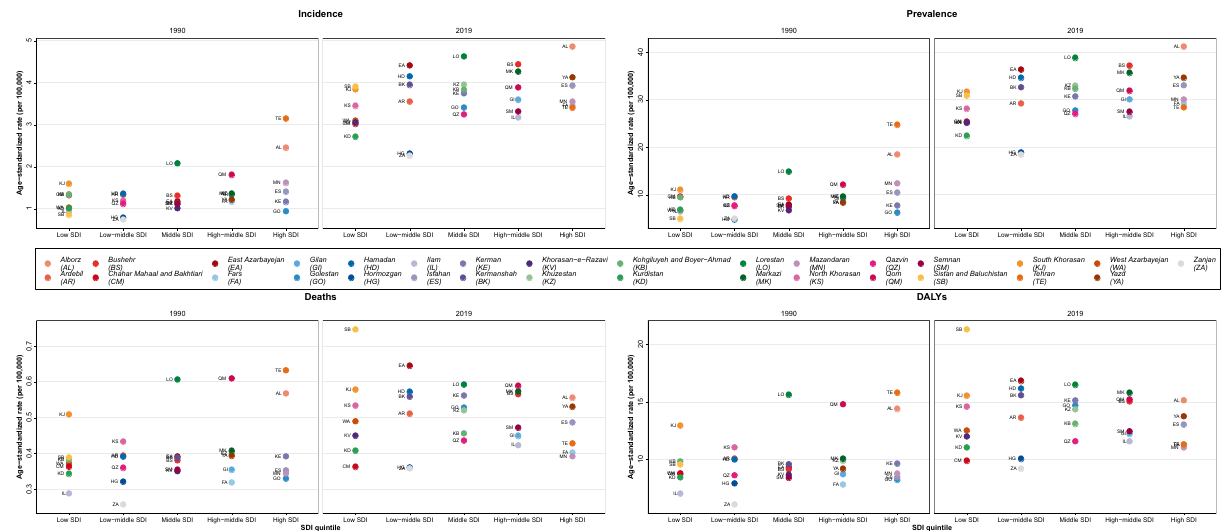
Figure 6. The thyroid cancer age-standardized incidence, prevalence, deaths, and DALYs in provinces of Iran in 1990 and 2019 by SDI